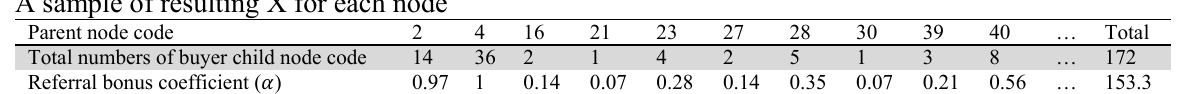
in each iteration (cid:2919)